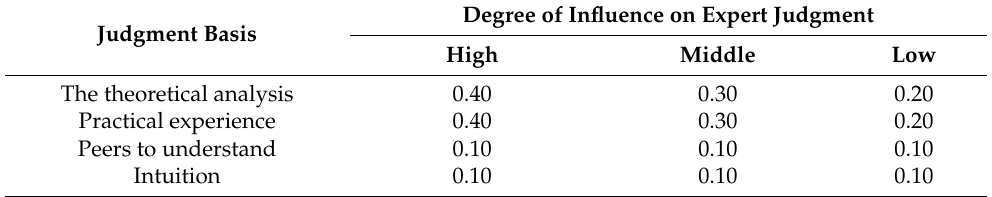
Table 2. Expert Judgment Basis and Assignment.